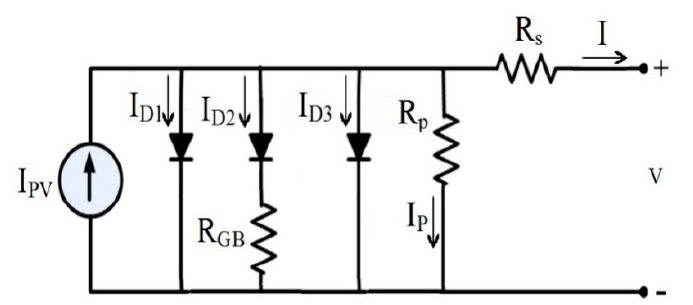
Figure 2. Modified three diode model.